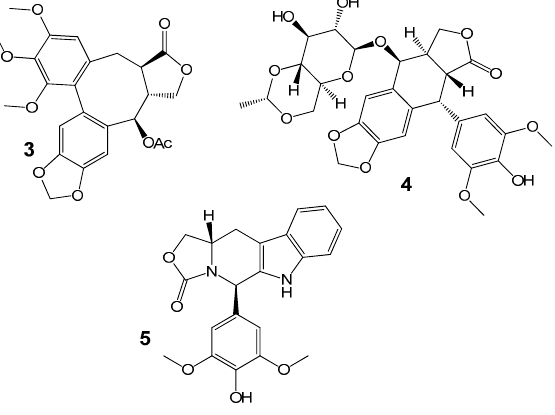
Figure 2. Structures of steganacin ( 3 ), etoposide ( 4 ) and azatoxin ( 5 ).